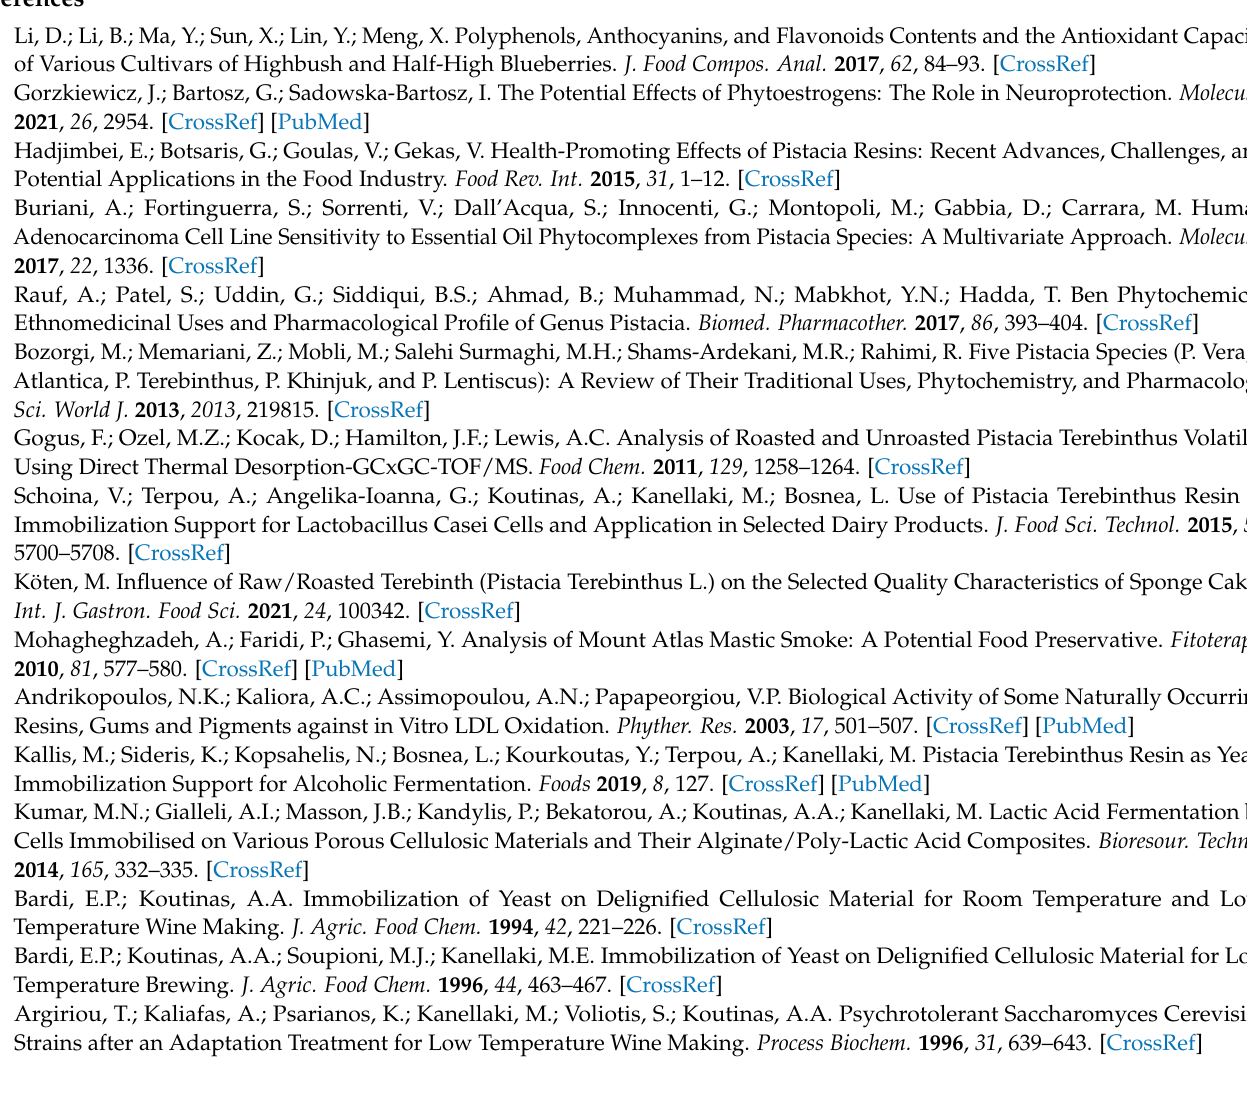
Table S12: Number of volatile compounds extracted from Pistacia terebinthus resin in methanolic solutions (20, 15, 10, 5 and 0%). References [23,24,40] are cited in the Supplementary Materials. Author Contributions: Conceptualization, M.K. (Michalis Kallis), M.K. (Maria Kanellaki) and